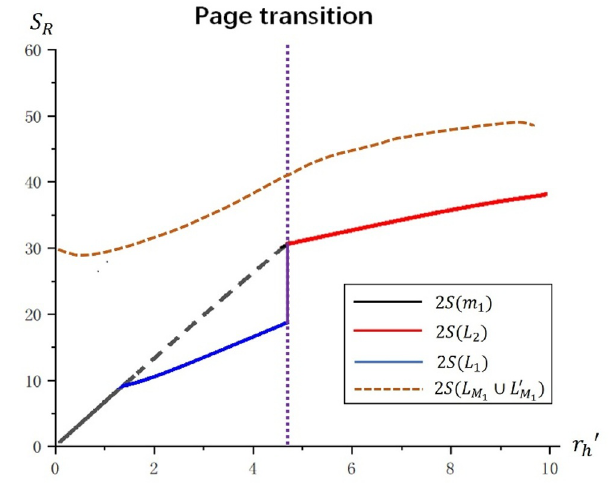
Figure 12 . The minimum of these curves is the reflected entropy between R 1 and R 2 . We can see that the reflected entropy goes through a jump at the Page transition